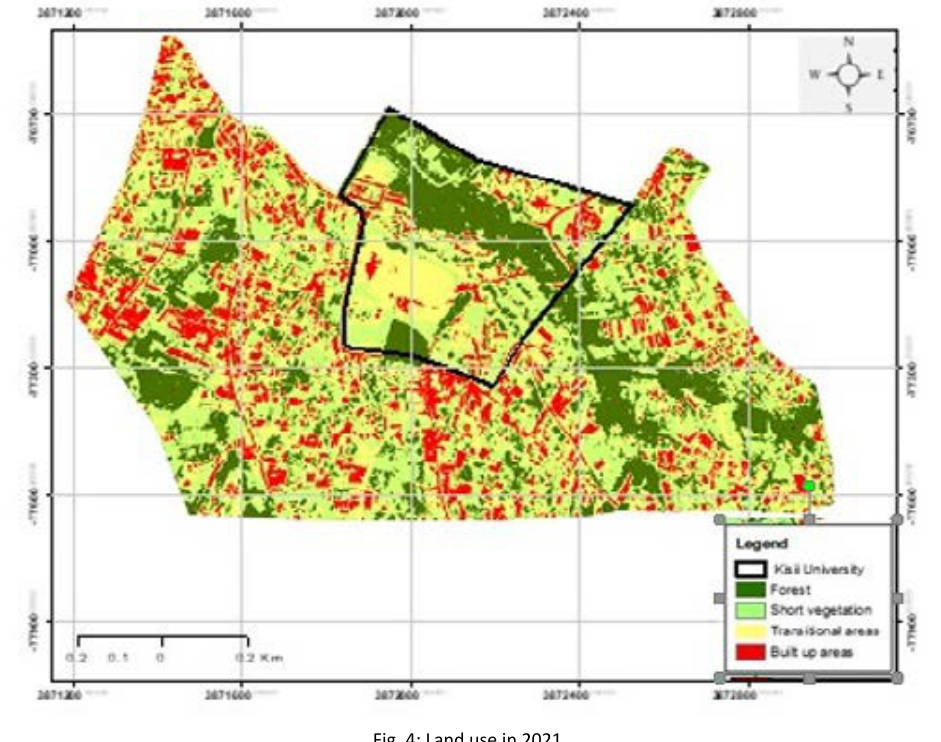
Fig. 4: Land use in 2021 Table 6. Confusion matrix for 2021 classification Table 6. Confusion matrix for 2021